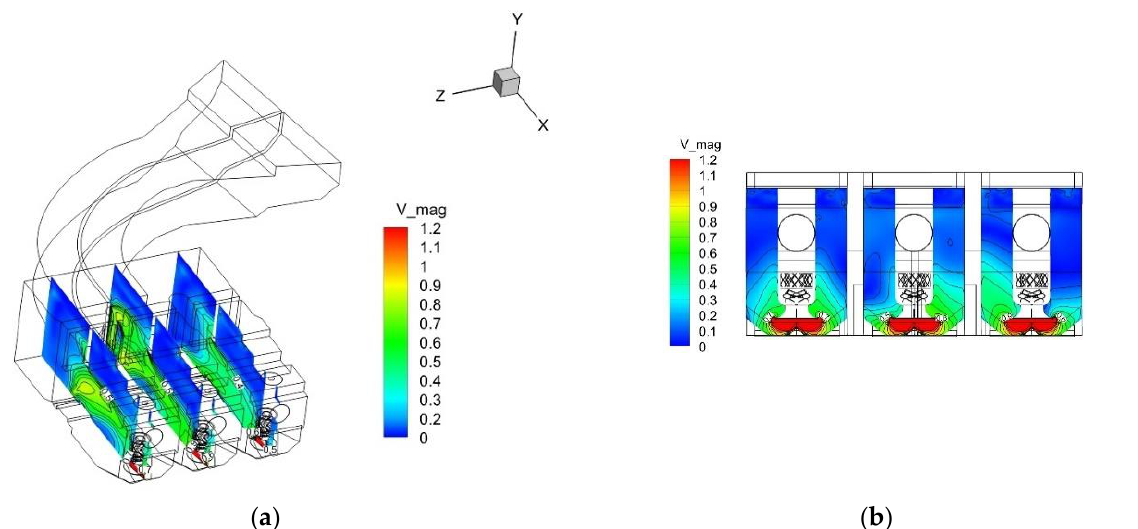
Figure 15. Plan 7 Isogram of velocity. ( a ) Center section of pump body along flow direction. ( b ) Center section of pump body in vertical flow direction.